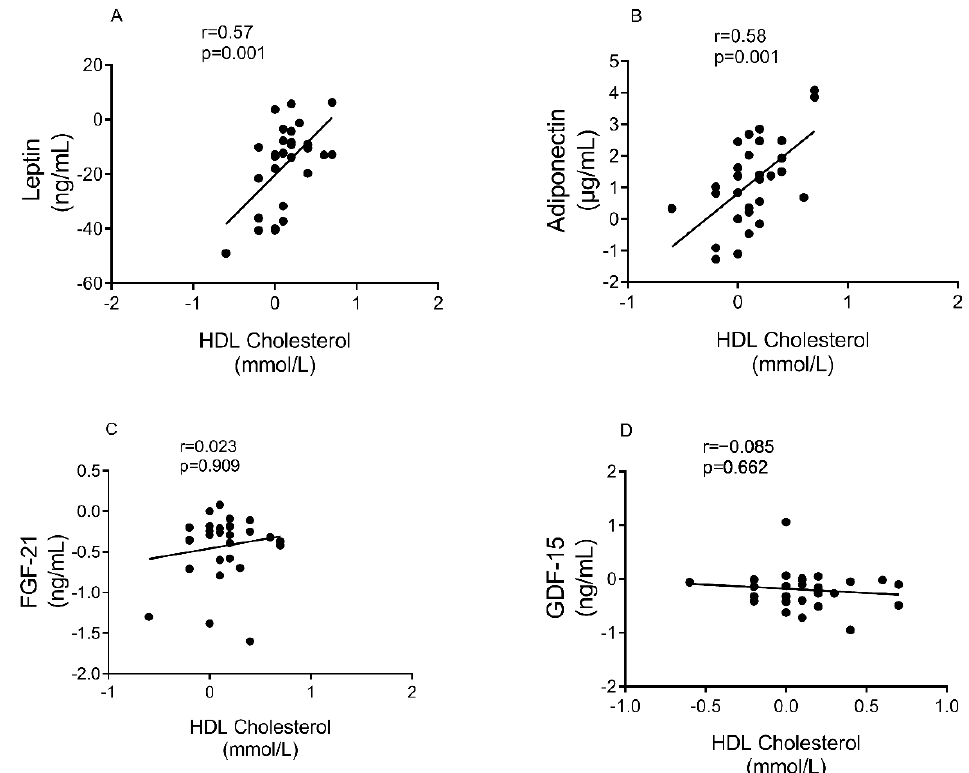
Figure 4. Correlation between changes in HDL cholesterol and plasma biomarkers. ( A ): Leptin, ( B ): Adiponectin, ( C ): FGF-21, and ( D ): GDF-15. 29 participants (12 responders/17 non-responders) were included. Spearman Rho /Pearson were used to assess correlation on the changes from baseline at 6 months.